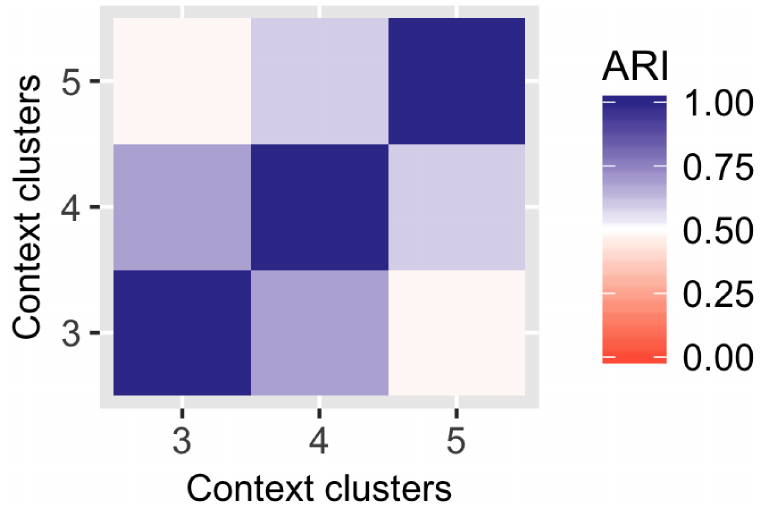
Fig 15. Consistency between global clustering results for different number of local context-specific clusters, as measuredby the ARI. The comparedmodels were trained with 18 globalclusters and 3 to 5 context-specific clusters.